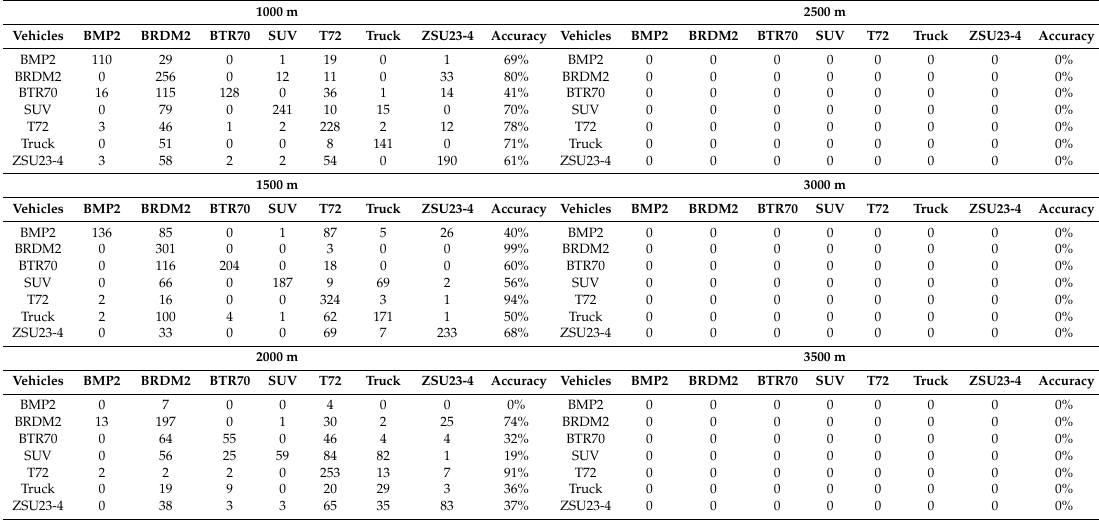
Table A11. Classification results for PCE 50 case (MWIR nighttime). Left shows the confusion matrix and the last column shows the classification